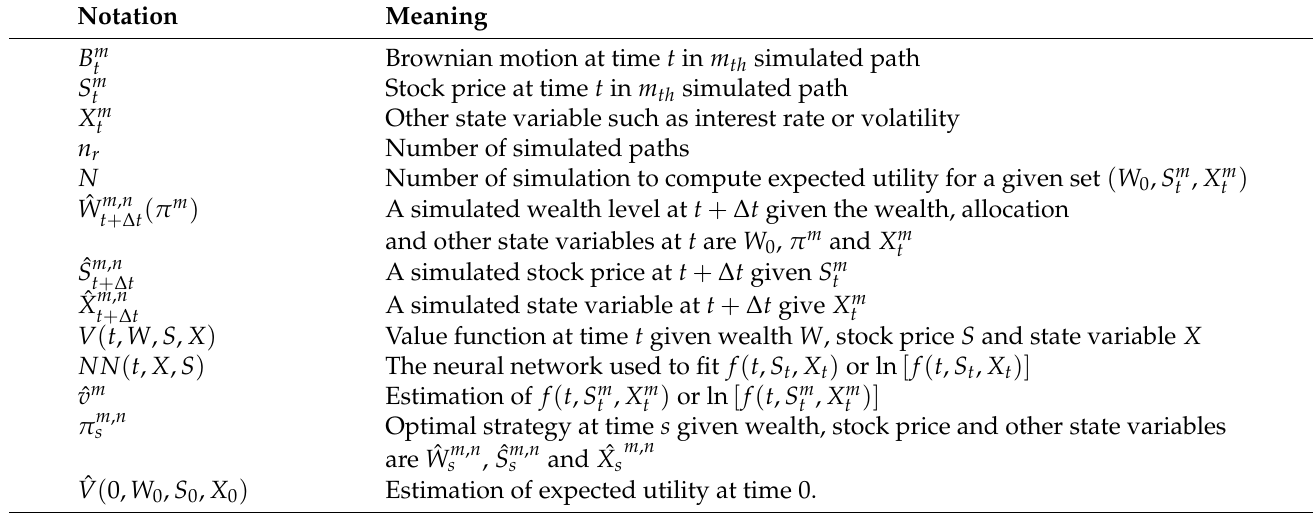
Table 1. Notation for NNMC is listed